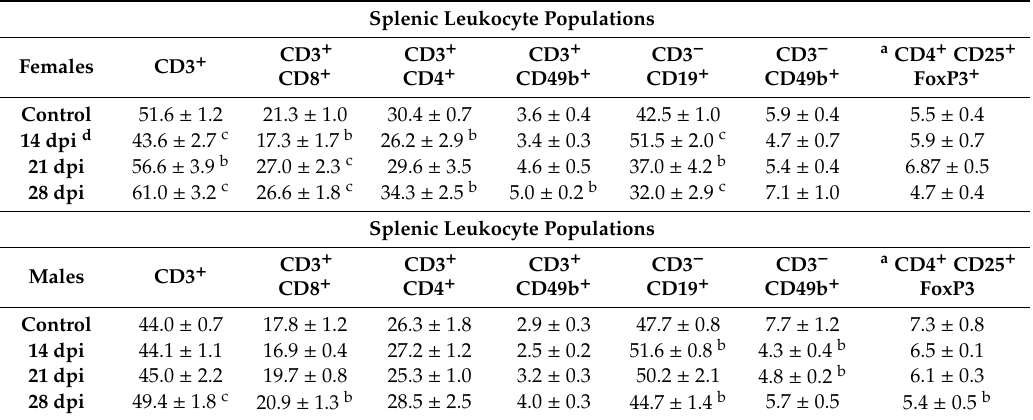
Table 1. Changes in splenic leukocyte